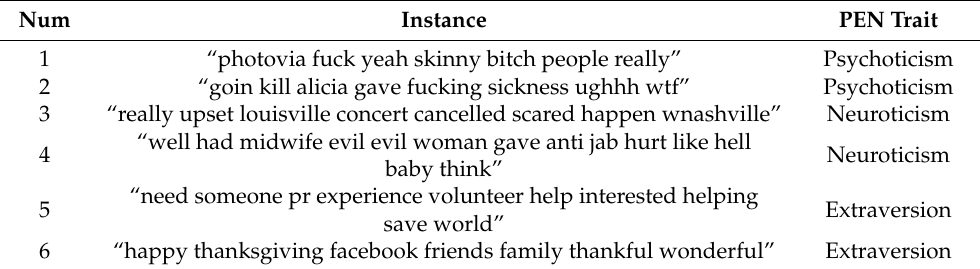
Table 6. Samples of SLDA generated Sentiment140 instances and the corresponding traits.